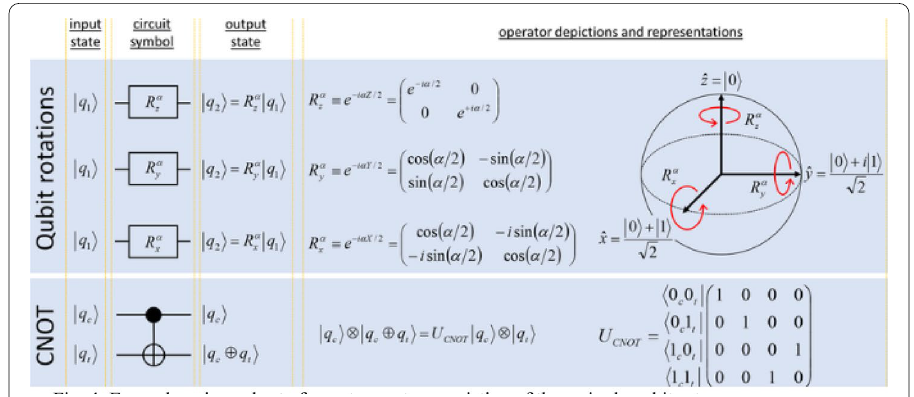
Fig. 4 Example universal set of quantum gates consisting of three single qubit rotation gates and one two-qubit CNOT gate, with circuit symbols, depictions, and representations